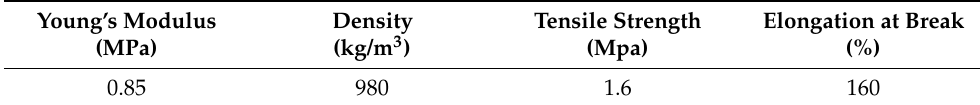
Table 2. Material parameters of silicone